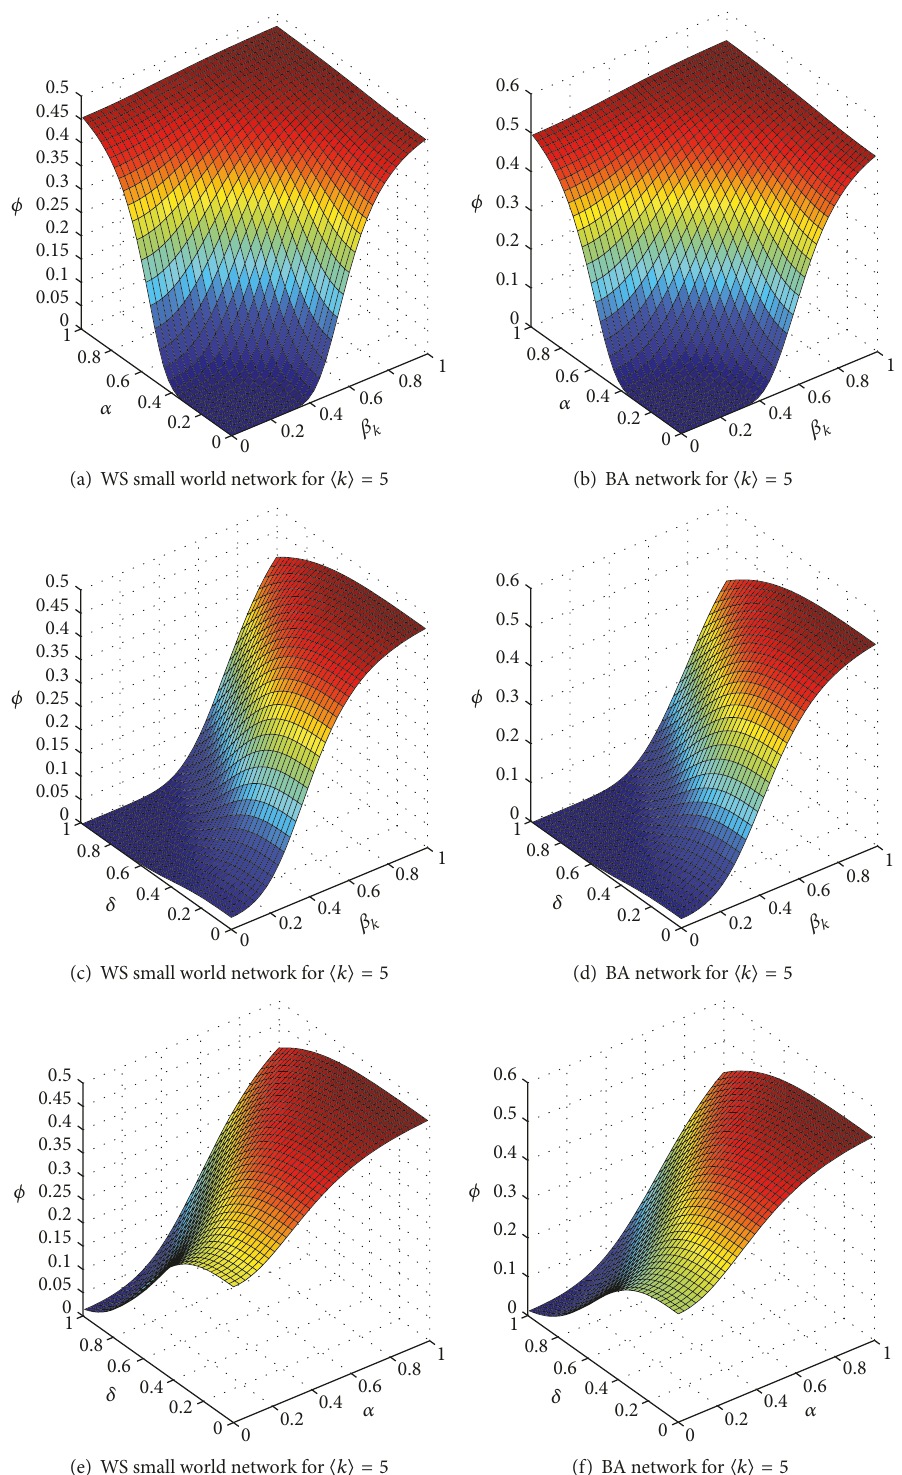
Figure 6: The influencing mechanism of the interaction among the effect degree 𝛼 of market noises, the risk preference level 𝛽 𝑘 of investors, and the supervision strength 𝛿 of financial market regulators on the contagious scale 𝜙 of credit risk under the different network structure. (a) and (b) for 𝛿 = 0.4 , 𝜃 = 0.5 , 𝜂 = 0.6 , 𝜇 = 0.3 , 𝜌 = 0.2 , 𝜆 = 0.3 , 𝑐 𝑘 = 0.1 ; (c) and (d) for 𝛼 = 0.3 , 𝜃 = 0.5 , 𝜂 = 0.6 , 𝜇 = 0.3 , 𝜌 = 0.2 , 𝜆 = 0.3 , 𝑐 = 0.1 ; (e) and (f) for 𝛽 = 0.6 , 𝜃 = 0.5 , 𝜂 = 0.6 , 𝜇 = 0.3 , 𝜌 = 0.2 , 𝜆 = 0.3 , 𝑐 = 0.1 𝑘 𝑘 𝑘